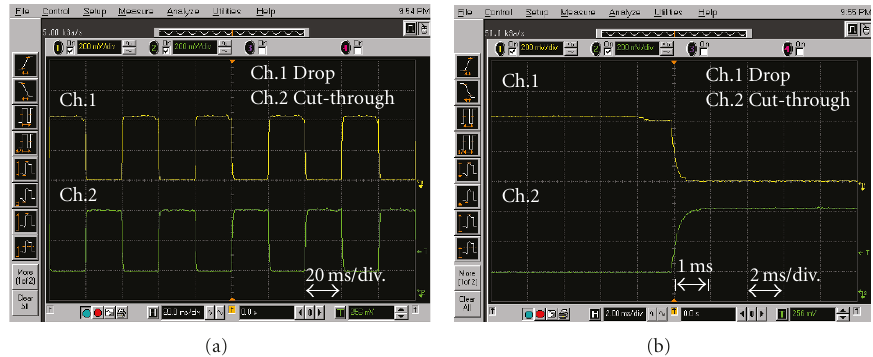
Figure 6: Measured response of reconfigure operation by the MEMS optical switch: (a) 20 ms/div and (b) 2ms/div.